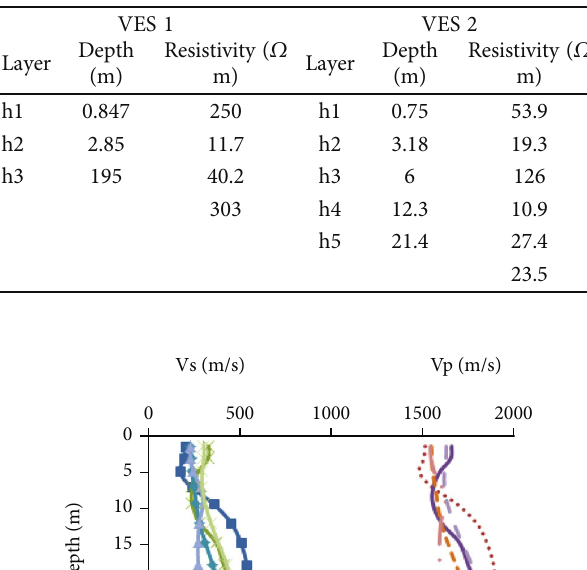
Table 4: Thickness (h) and resistivity ( ρ ) of VES 1 and VES 2 at Hawassa town.